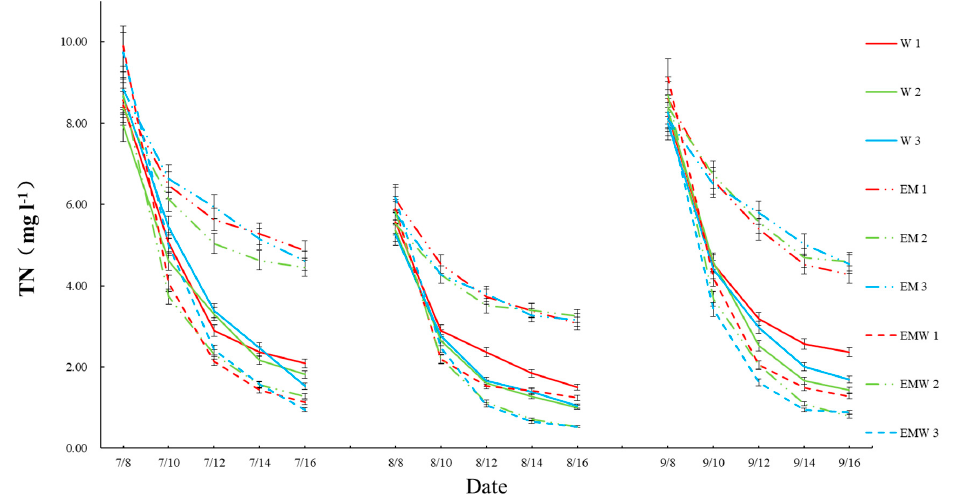
Figure 2. Total nitrogen (TN) concentration changes with time in wetlands.